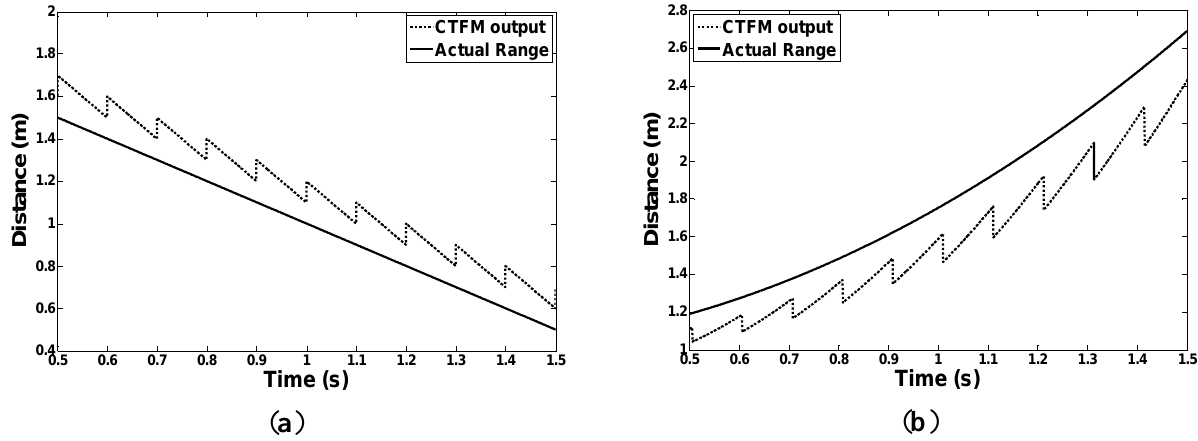
Figure 5. The CTFM output vs. the actual target distance. ( a ) A target approaching